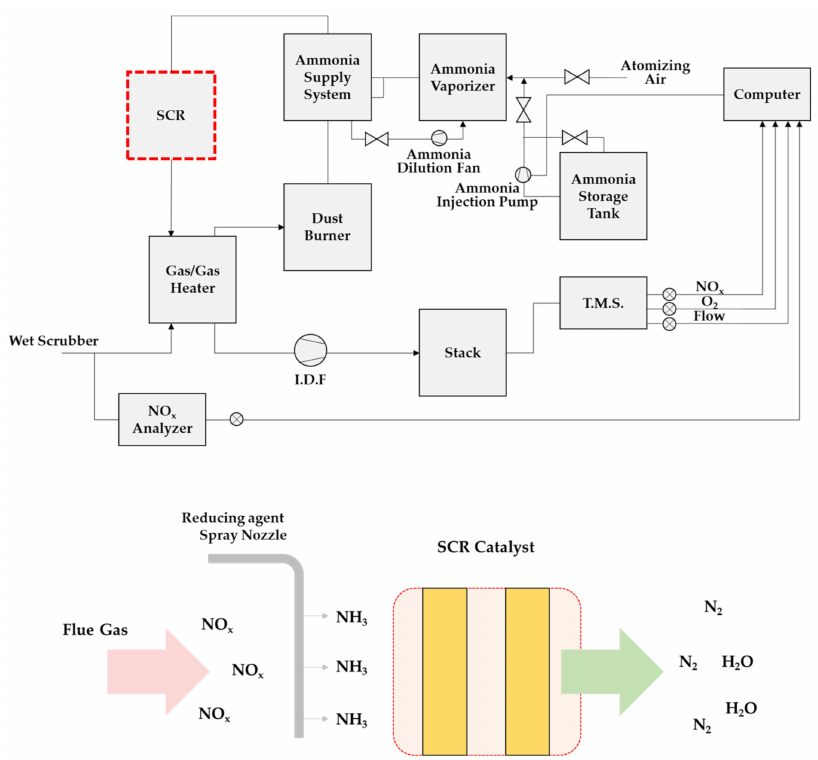
Figure 13. SCR system design and mechanism of SOOM Environ. Tech. (data taken from [34]).